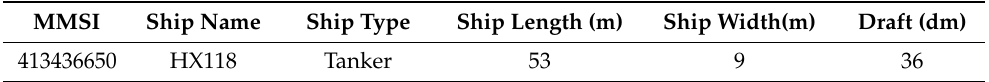
Table 3. Smuggling ship static information table.